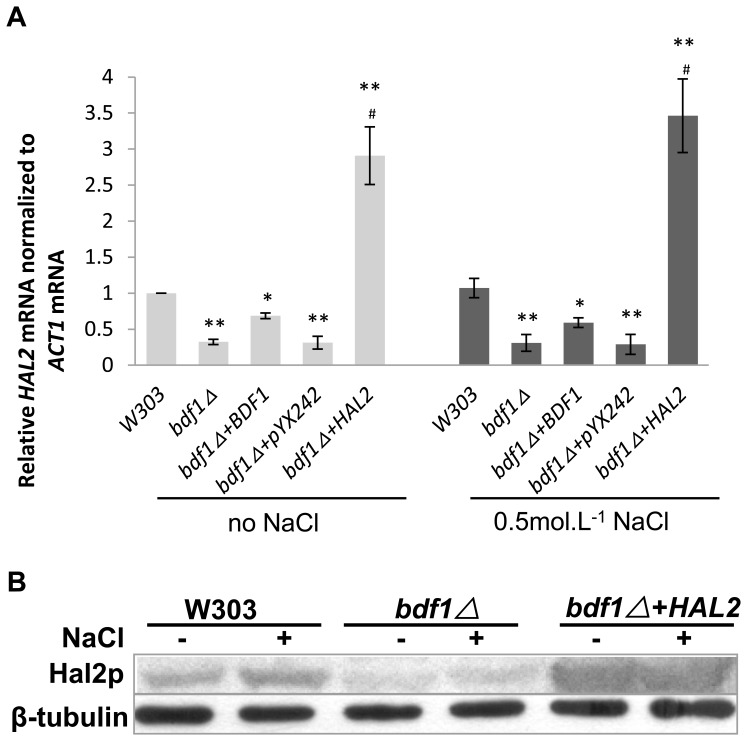
Deletion of BDF1 reduced HAL2 expression at both mRNA and protein levels.The mid-log phase cultures in YPD at 30°C were incubated for 45 min with or without 0.5 mol.L−1 NaCl. (A) Relative fold-changes of HAL2 mRNA were calculated against the wild type without NaCl treatment. Error bars denote standard deviation (SD). **P<0.01 vs. wild type under the same treatment, # P<0.01 vs. bdf1Δ under the same treatment, n = 3. (B) The Hal2p protein level was analyzed with whole cell protein by Western blot. β-tubulin was used as control. The polyclonal Hal2p antibody and anti-β-tubulin antisera were used in Western blot analysis.